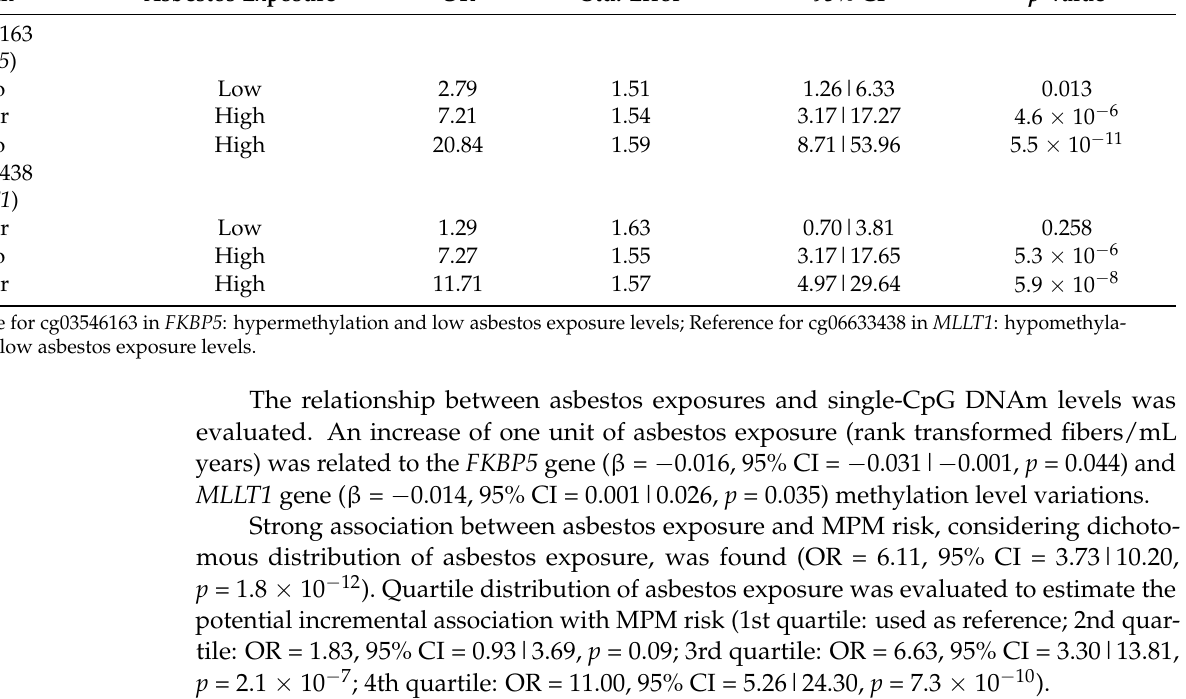
Table 3. Interaction between asbestos exposure and single CpG DNAm on the MPM Odds ratios.